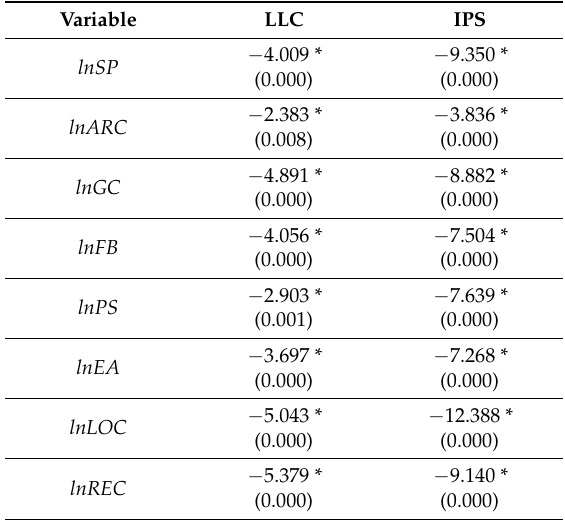
Table 2. Unit root test results for the Mediterranean